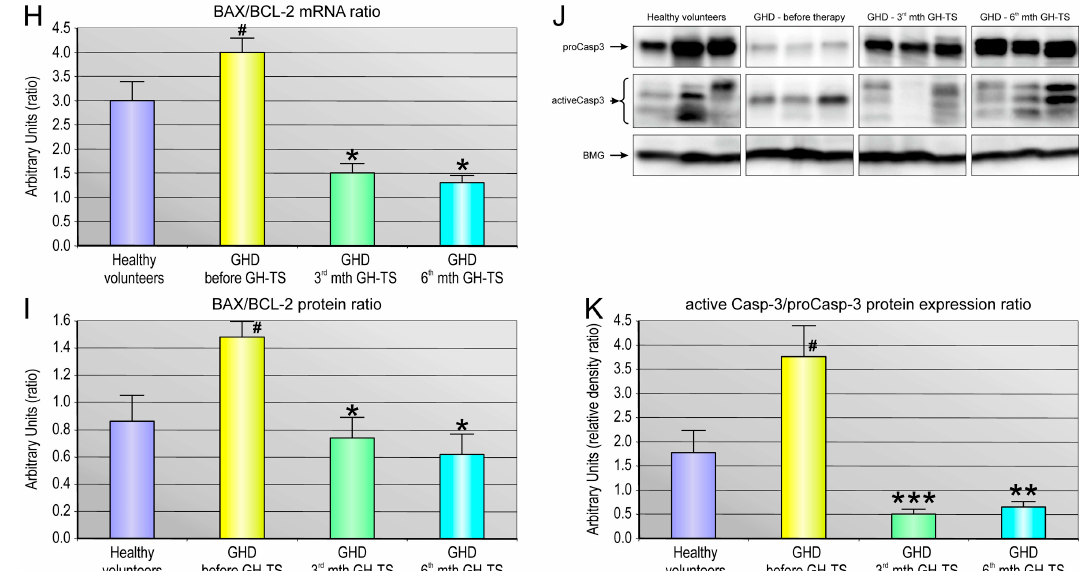
Figure 4. The expression profile of selected apoptosis-related molecules, BCL-2, BCL-XL, BAX and caspase-3 in CD34+ cells from GHD patients. The expression of selected apoptosis-related gene transcripts and proteins was evaluated in CD34+ cells of controls and GHD patients at different time points (before GH-TS and in the 3rd and 6th month of GH-TS). The mRNA expression of BCL-2 ( A ); BCL-XL ( D ), and BAX ( E ) was determined by the quantitative PCR. The mRNA levels are expressed in arbitrary units as the mean value ± S.D. The protein expression of BCL-2 ( B , C ); BAX ( F , G ); caspase-3 and procaspase-3 ( J , K ) was determined by western blot. Beta-2-microglobulin (BMG) served as loading control. Protein bands were analyzed by densitometry. Bars represent mean ± S.D. of selected protein to BMG ratio calculated in all examined groups. The ratio between the optical densities measured in 11-, 17- and 20-kDa cleaved caspase-3 and 32-kDa procaspase-3 bands was calculated as an index of caspase-3 activation. In addition, the BAX/BCL-2 mRNA ( H ) and protein ( I ) ratio was calculated. * p < 0.05 vs. GHD patients prior to GH-TS. ** p < 0.01 vs. GHD patients prior to GH-TS. *** p < 0.001 vs. GHD patients prior to GH-TS. # p < 0.05 vs. control values. ## p < 0.01 vs. control values.